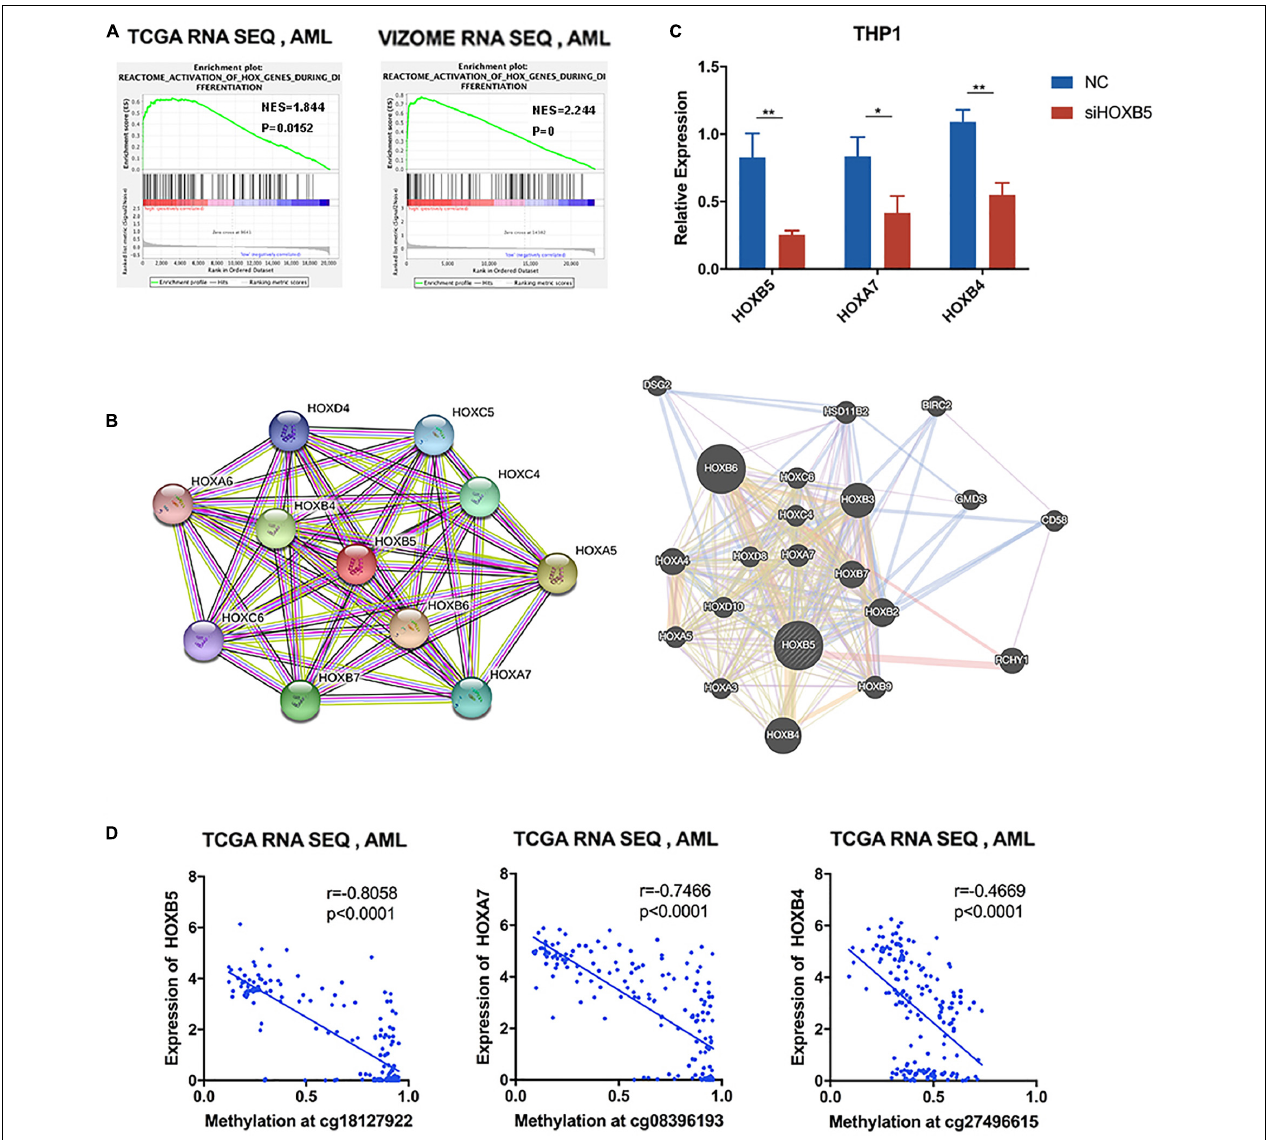
FIGURE 5 | HOXB5-related homeobox genes functioned together with HOXB5 in AML. (A) GSEA analyses verifying the function of HOXB5 in activation of HOX genes during differentiation. (B) Protein–protein interaction of HOXB5 using STRING and GeneMANIA. (C) The expression changes of HOXB5 and its related HOX genes (HOXA7 and HOXB4) after knockdown of HOXB5 (with t test). (D) The correlation between HOXB5, HOXA7, and HOXB4 expression and their methylation level at locus cg18127922, cg08396193, and cg27496615, respectively, with methylation data of TCGA (with Pearson correlation analysis). * P < 0.05, ** P <